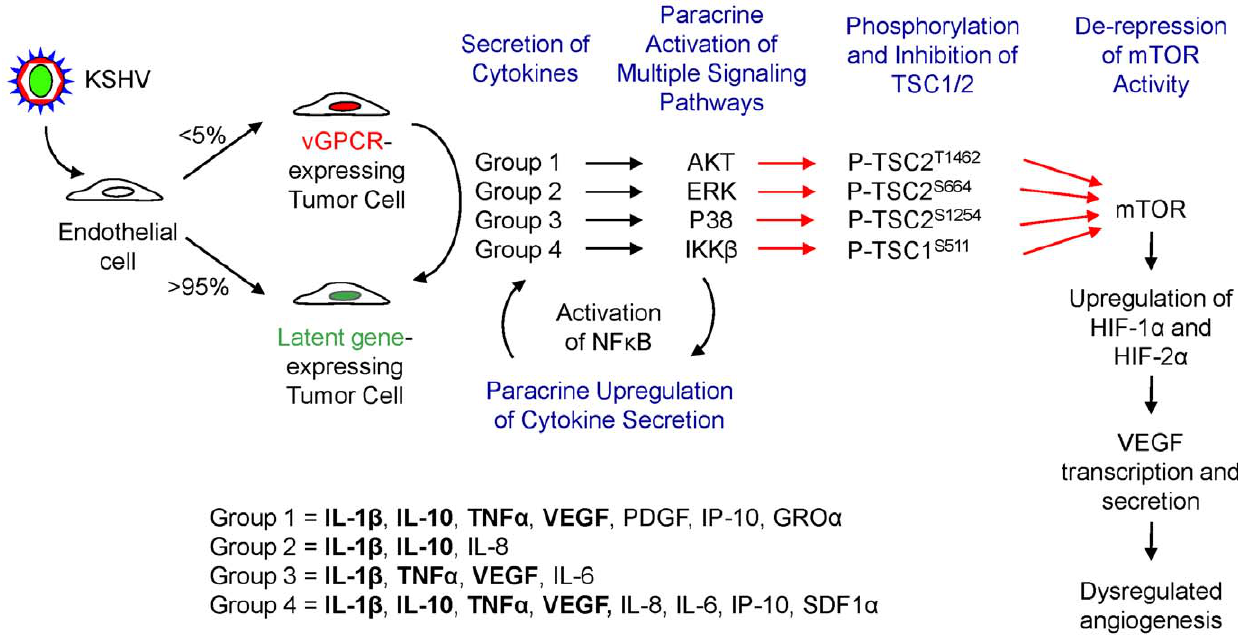
Figure 7. vGPCR cytokines activate VEGF secretion through diverse signaling cascades converging in TSC/mTOR/HIF. Schematic showing the different signaling pathways by which vGPCR cytokines, chemokines and growth factors converge in the phosphorylation of TSC1/2, the activation of mTOR and the upregulation of HIF levels, leading to VEGF secretion.